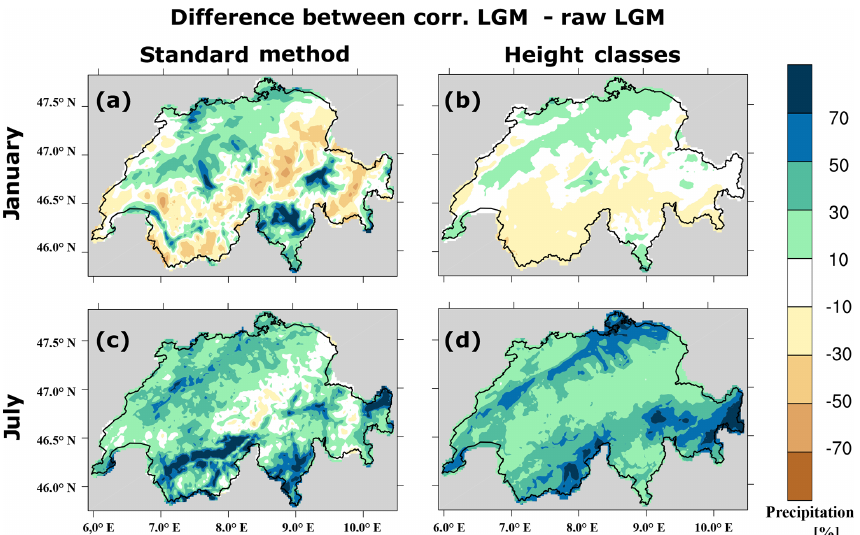
Figure 12. Performance of the correction for the monthly climatology of 30-year precipitation over Switzerland during the LGM. Panel (a) represents the differences in January between corrected precipitation using the standard EQM and uncorrected precipitation; panel (b) is the same as (a) but using the new method; panels (c) and (d) are the same as (a) and (b) but in July,